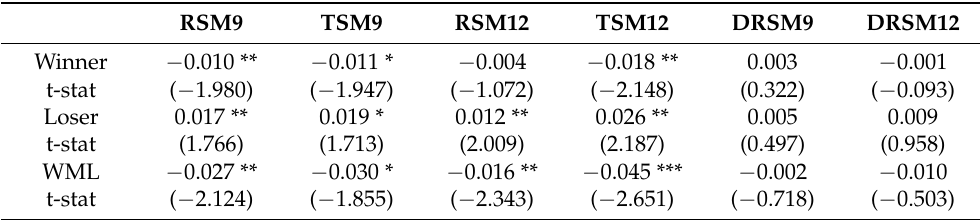
Table 5. Month lagged effect of Chinese EPU index on momentum strategies in the Chinese stock market. *** denotes significant at 0.01 level, ** denotes 0.05 significance level, and * represents significant at 0.1 level, respectively.